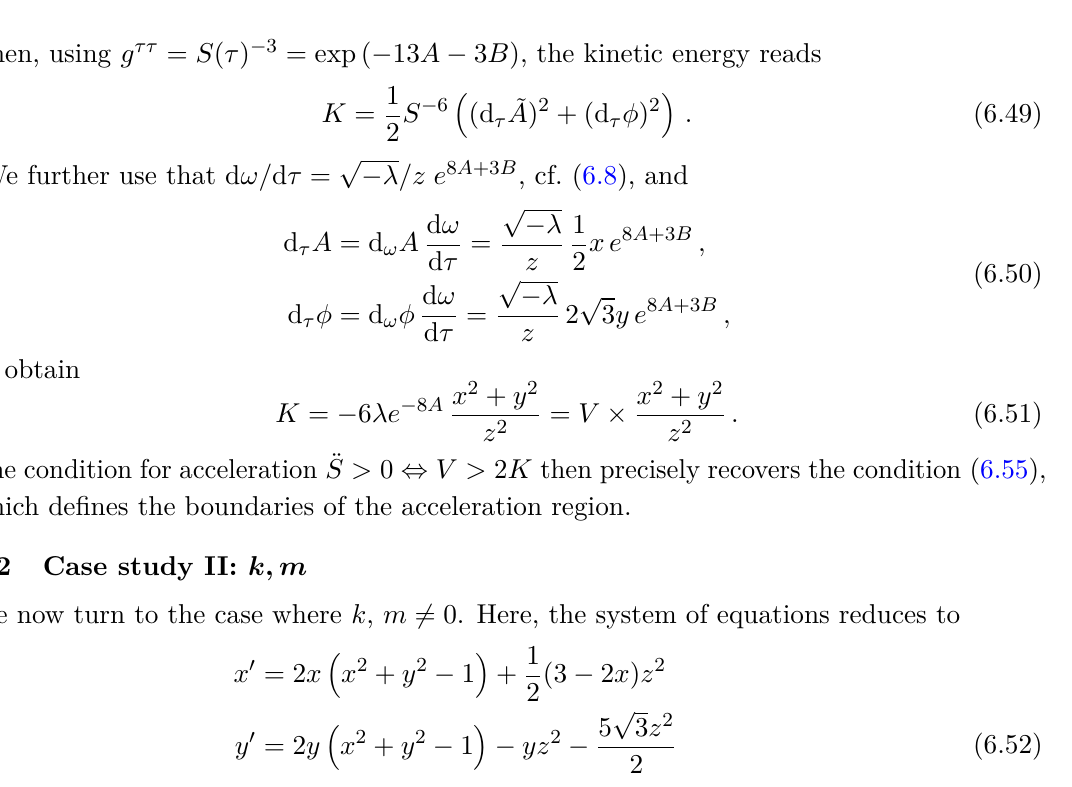
Figure 9 . The scalar potential V plotted over the field space ( A, φ ) . On it lies a typical trajectory featuring transient inflation: acceleration starts at the green dot and stops at the red dot. A these two special positions, the potential energy equals twice the kinetic